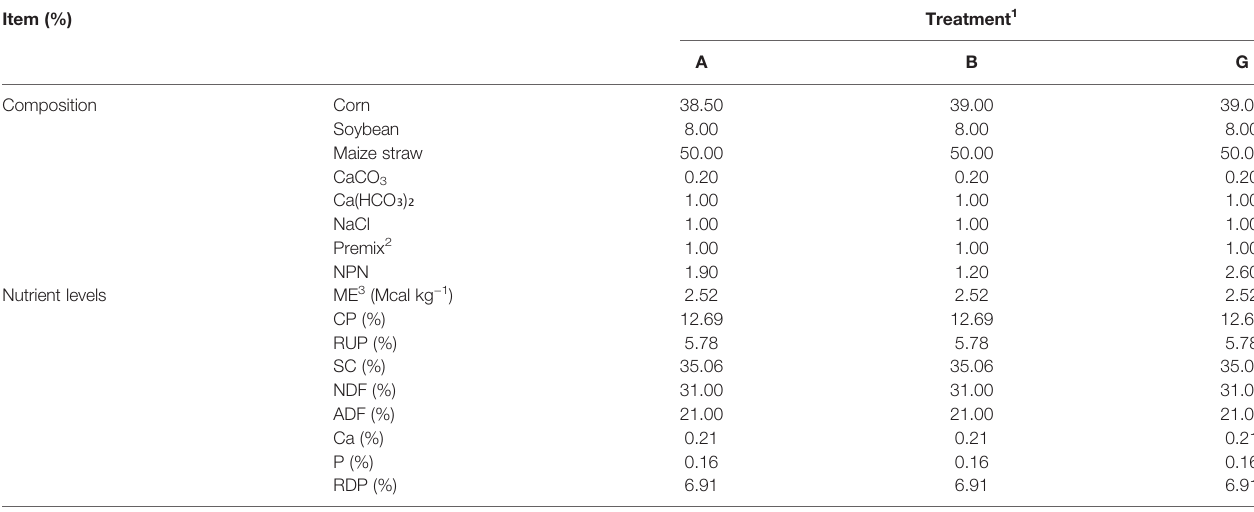
TABLE 1 | Composition and nutrient levels of non-protein nitrogen (NPN) diets (on dry matter basis). Item